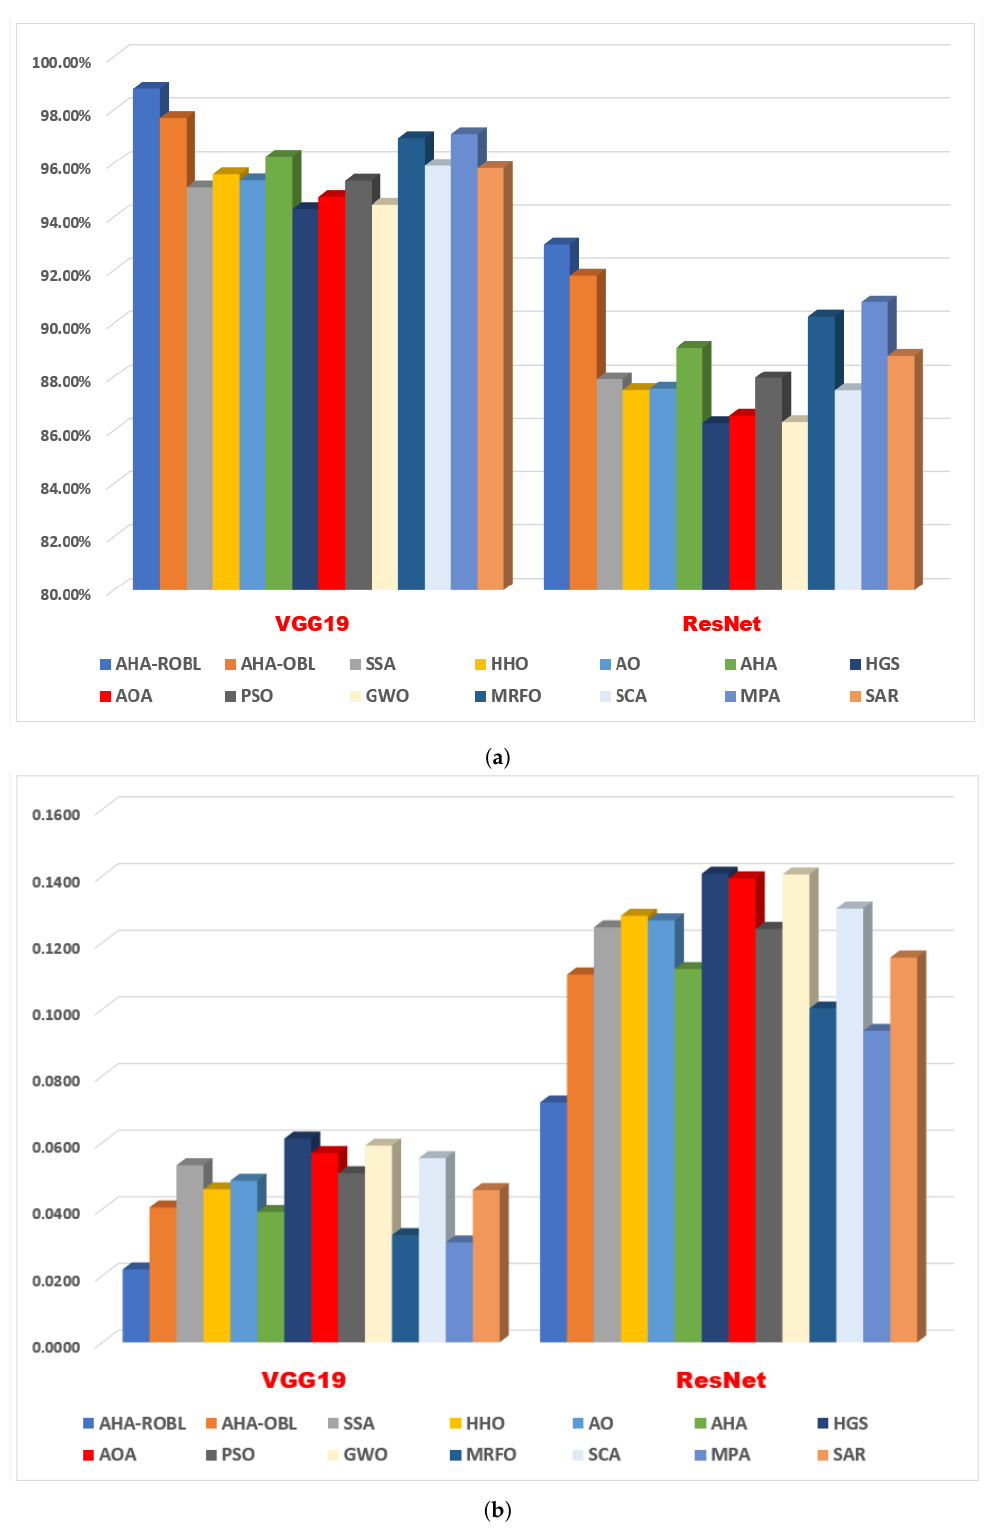
Figure 8. ( a ) Avg. accuracy of the proposed approaches versus other algorithms using VGG19 and ResNet20 and ( b ) avg. fitness of the proposed approaches versus other algorithms using VGG19 and